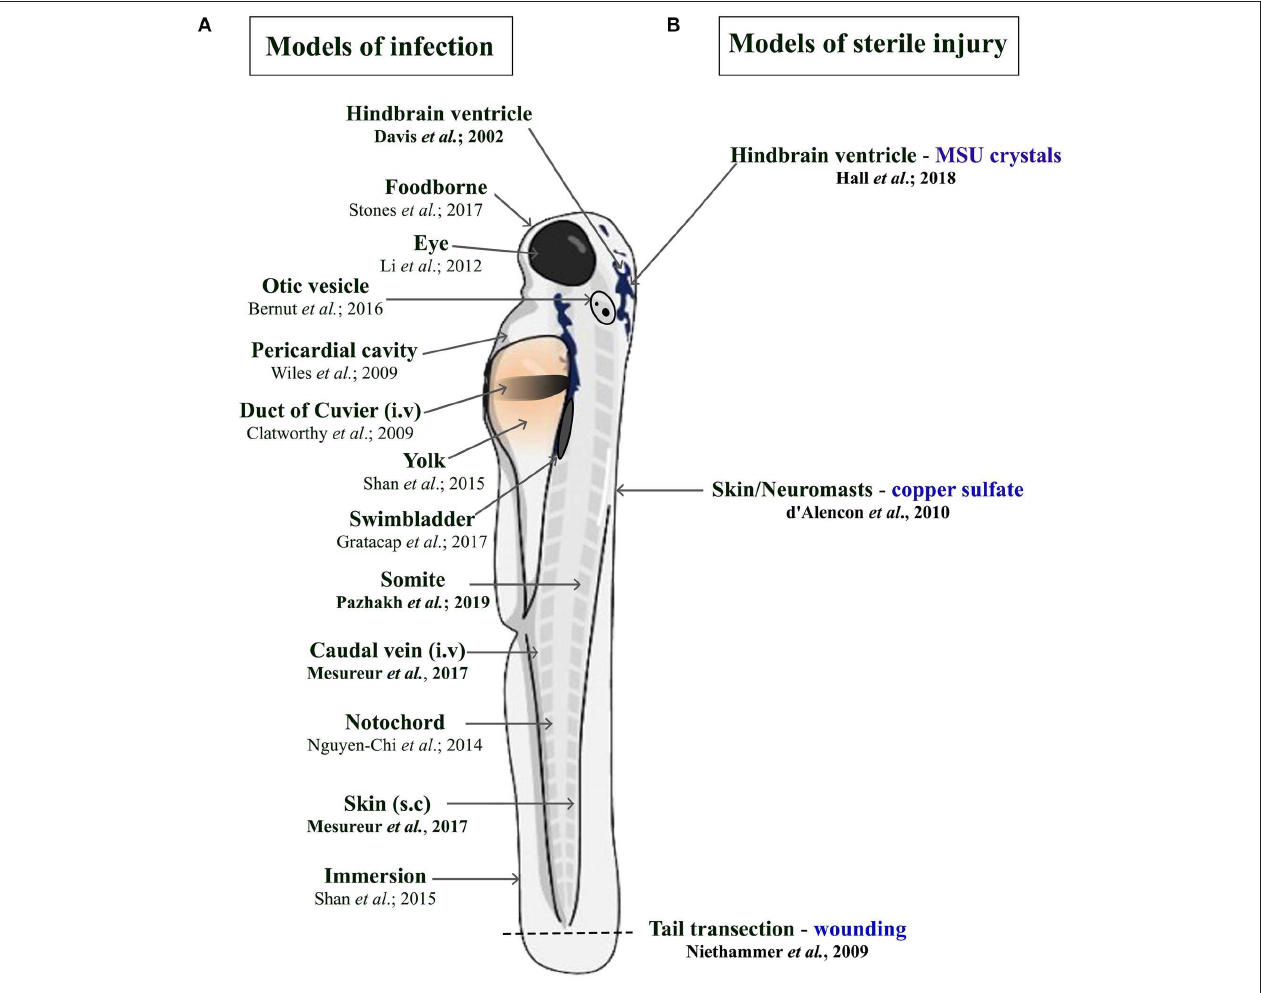
FIGURE 1 | Schematic illustration of the different delivery routes in larval zebrafish for pathogens. ( A , left side) and to model sterile inflammation ( B , right side). In the sterile injury section, the stimulus is specified by blue writing. All delivery routes show an exemplary reference, with the ones covered in this review highlighted in bold.